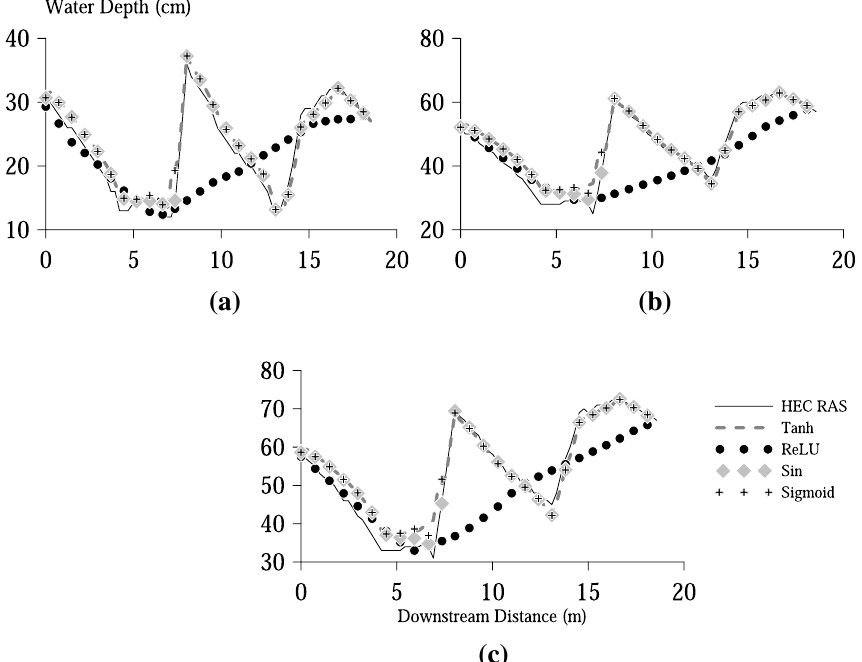
Fig. 7 PINN results with the best case for each activation function for Step‑pool: a Low flow, b Mid flow, and c High